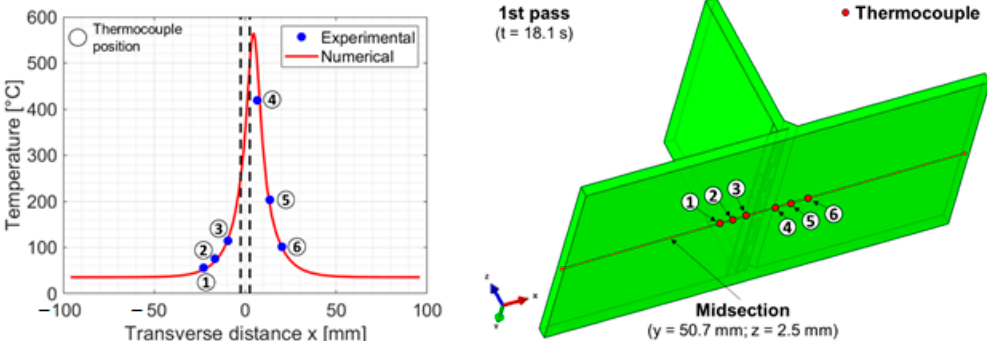
Figure 11. Experimental vs. numerical transverse temperature distributions in the flange in midsection ( y = 50.7 mm and z = 2.5 mm) at time t = 18.1 s during the first welding pass.